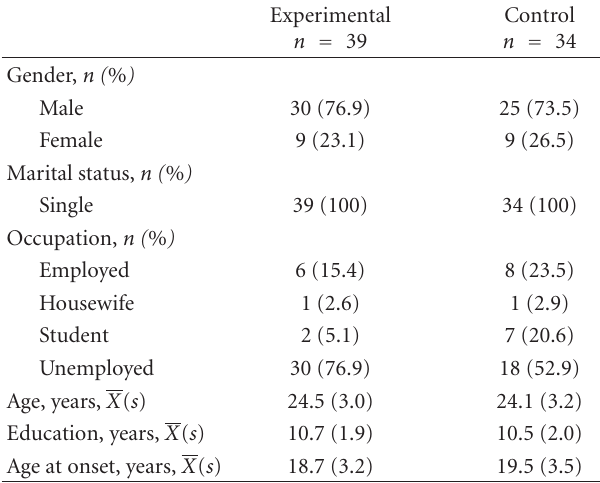
Table 1: Sociodemographic and clinical characteristics of the